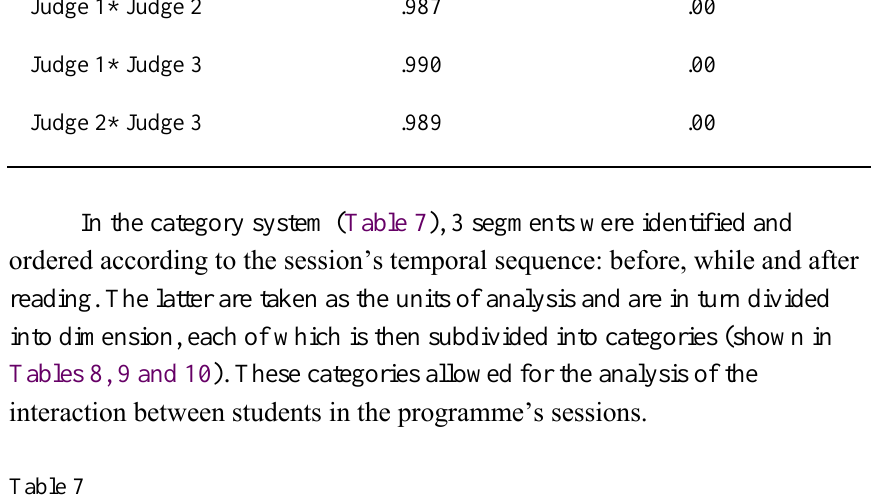
Results of the interactivity